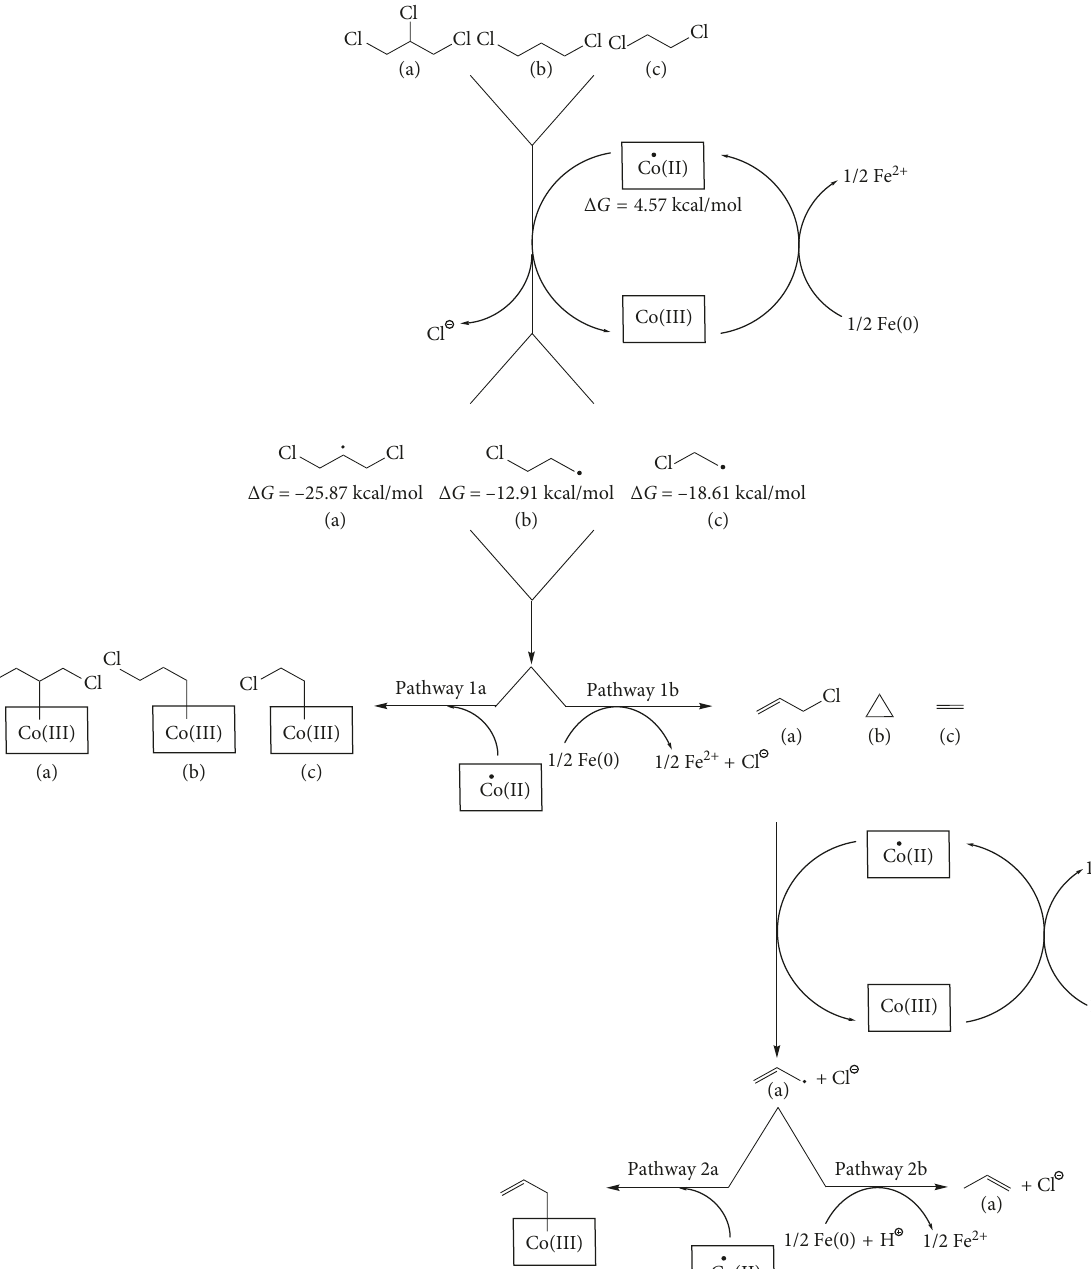
Figure 8: Mechanistic pathway for (a) 1,2,3-TCP, (b) 1,3-DCP, and (c)